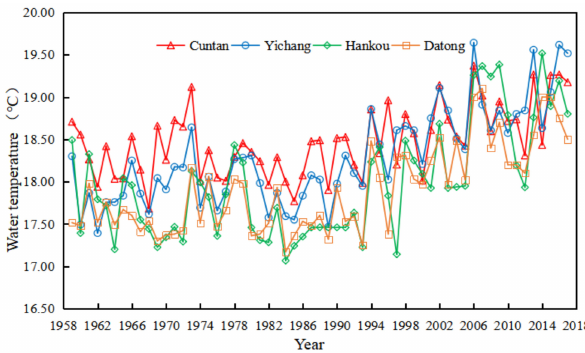
Figure 2. Annual average water temperature variation of the Yangtze